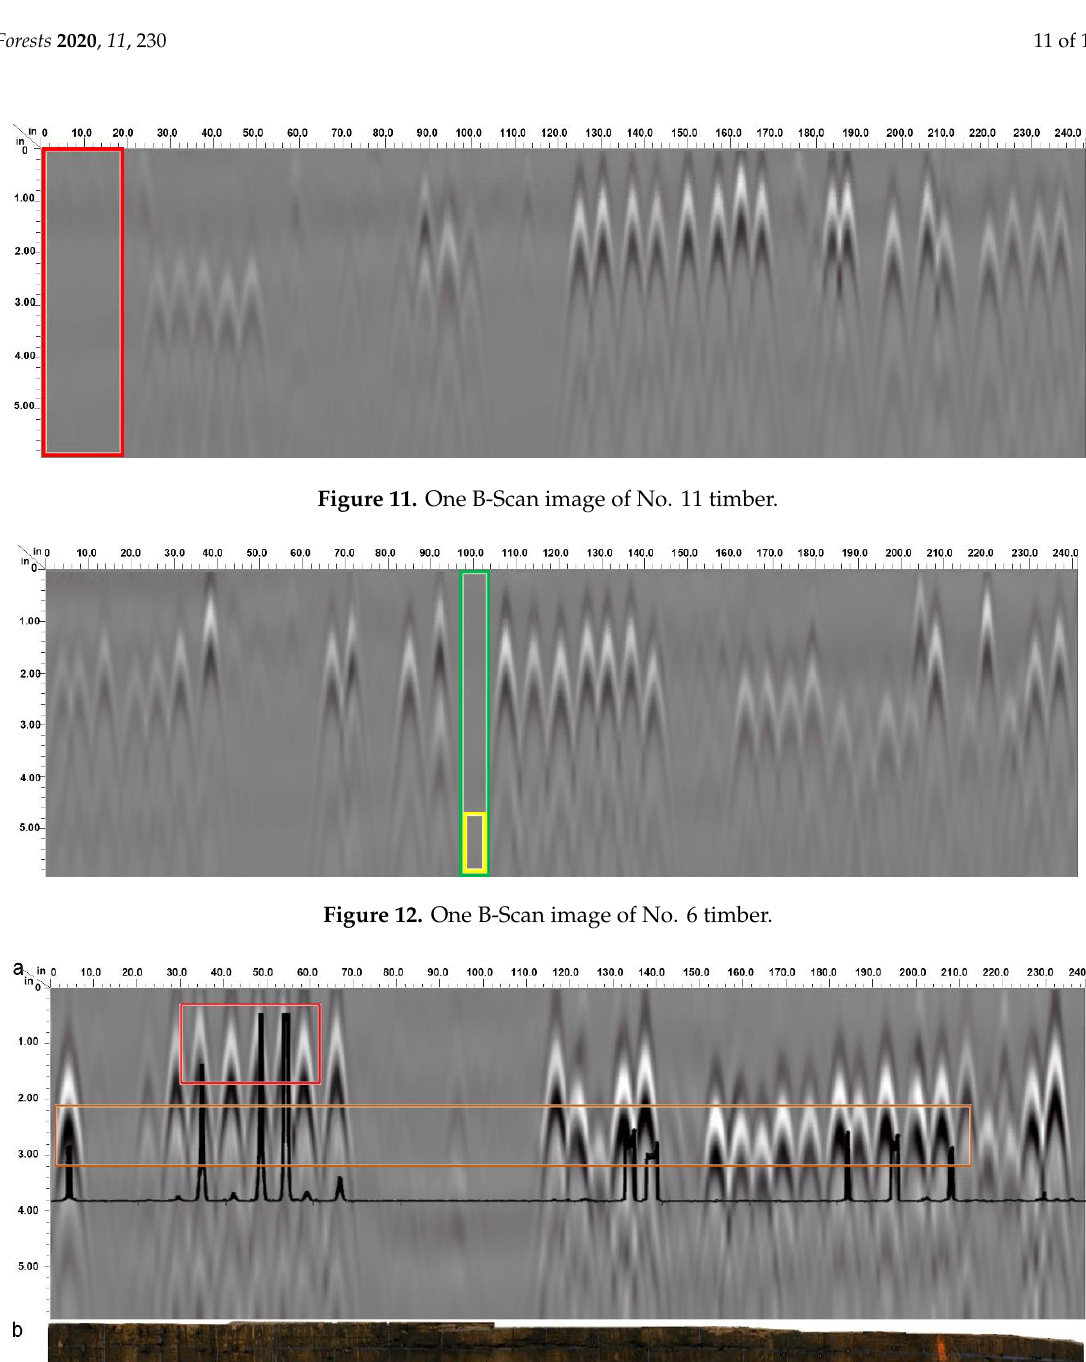
Figure 13. The combined image for the line chart of dynamic time warping (DTW) value, the radargrams generated from RADAN 7, and the outside camera pictures (sample NO. 10). ( a ) The results made up of the radargrams and the line chart of similarity; ( b ) The outside image of one side of No. 10 timber. The similarity value in the red rectangle usually appeared if there are at least 2